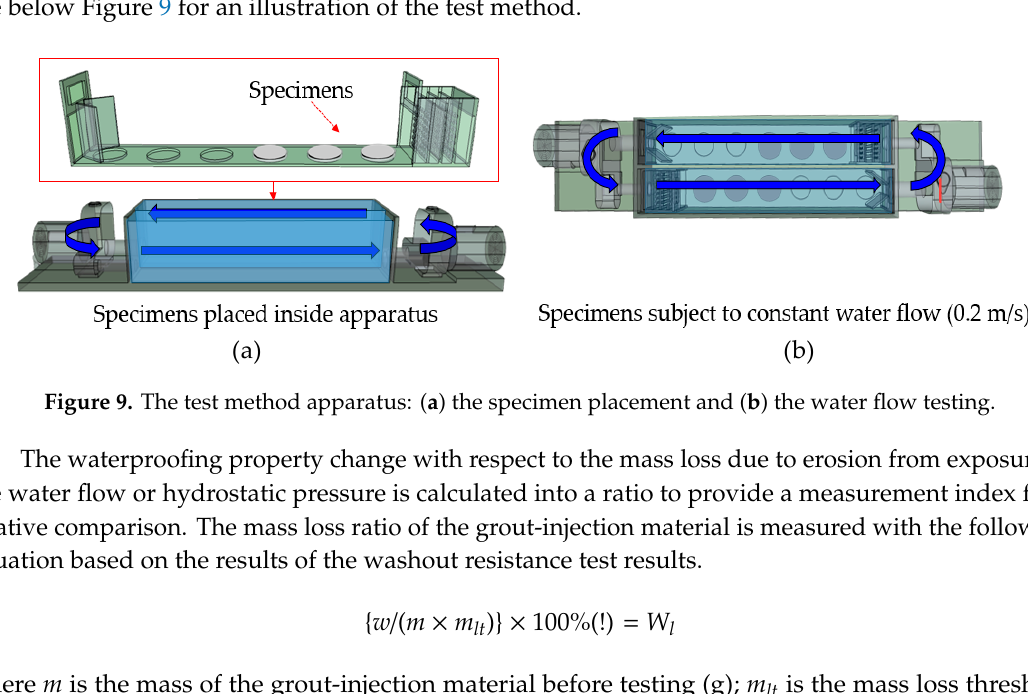
Figure 8. The test method apparatus: ( a ) exposure to the chemical solution and ( b ) the mass measurement after exposure.